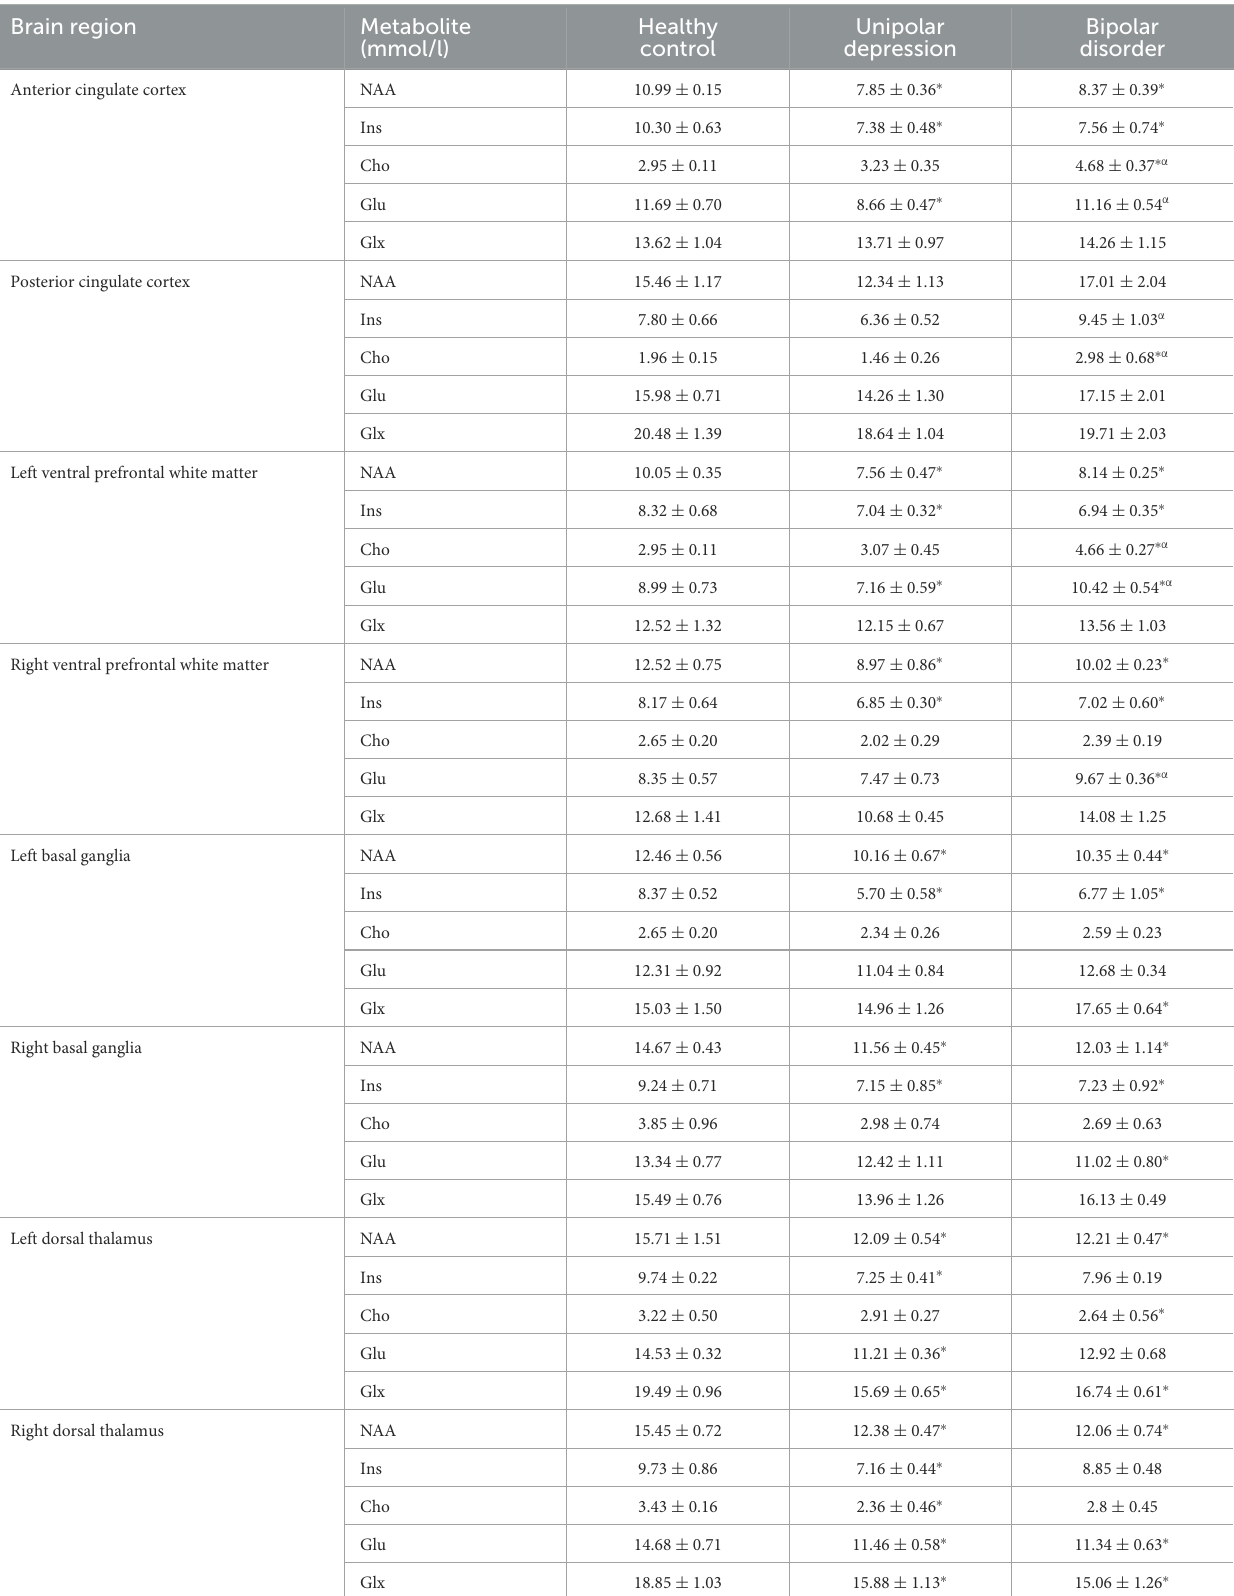
TABLE 3 Shows the metabolic values in the eight brain regions analyzed in the three